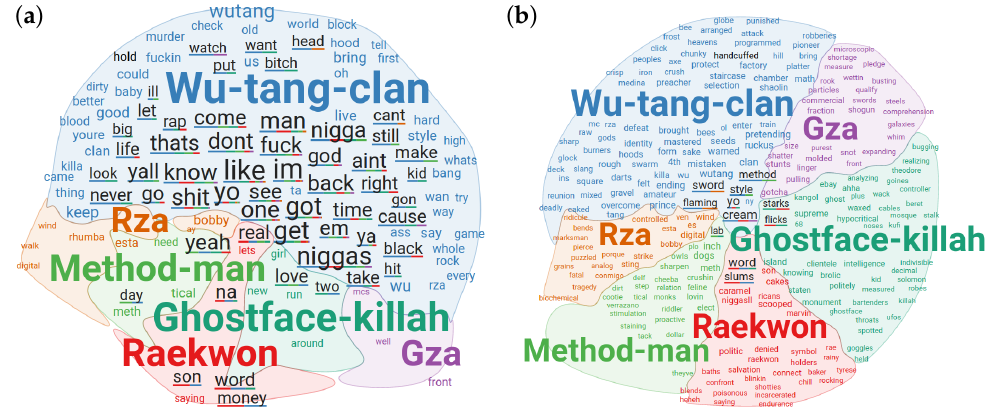
Figure 10. TagPie showing the most frequent used words by the Wu Tang Clan and various mem- bers ( a ). TagPie ( b ) shows words by z-score, e.g., words that are more frequent than the rest of the